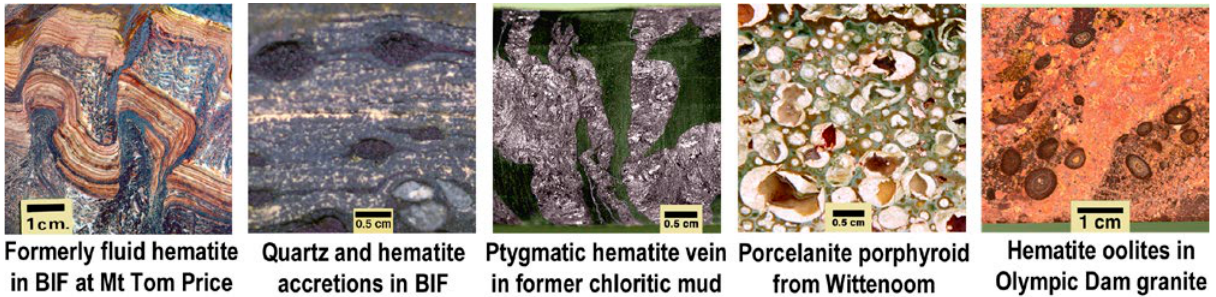
Figure 10. Former mobility of iron ore, accretions, ptygmatic folding, and concretions are now